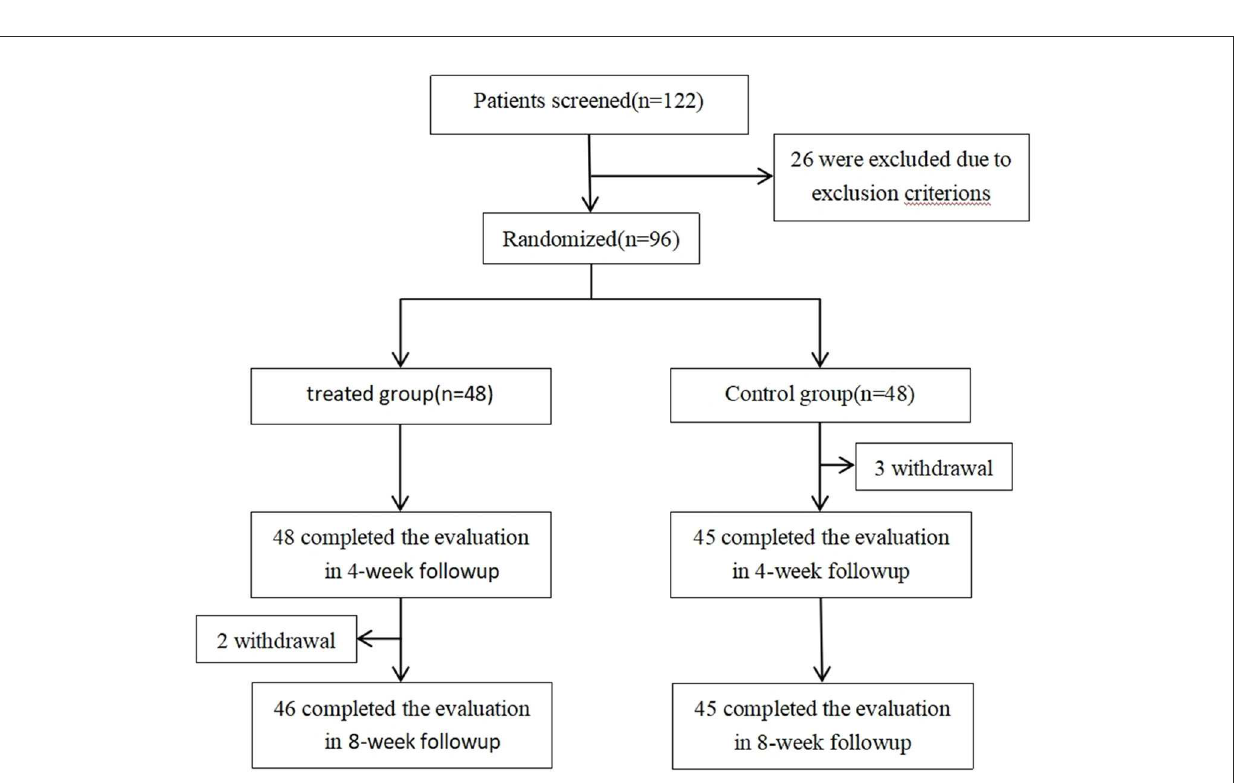
FIGURE2 Flow diagram of participant screening and